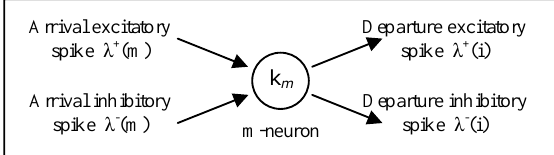
Figure 1. The Random Neural Network (RNN).